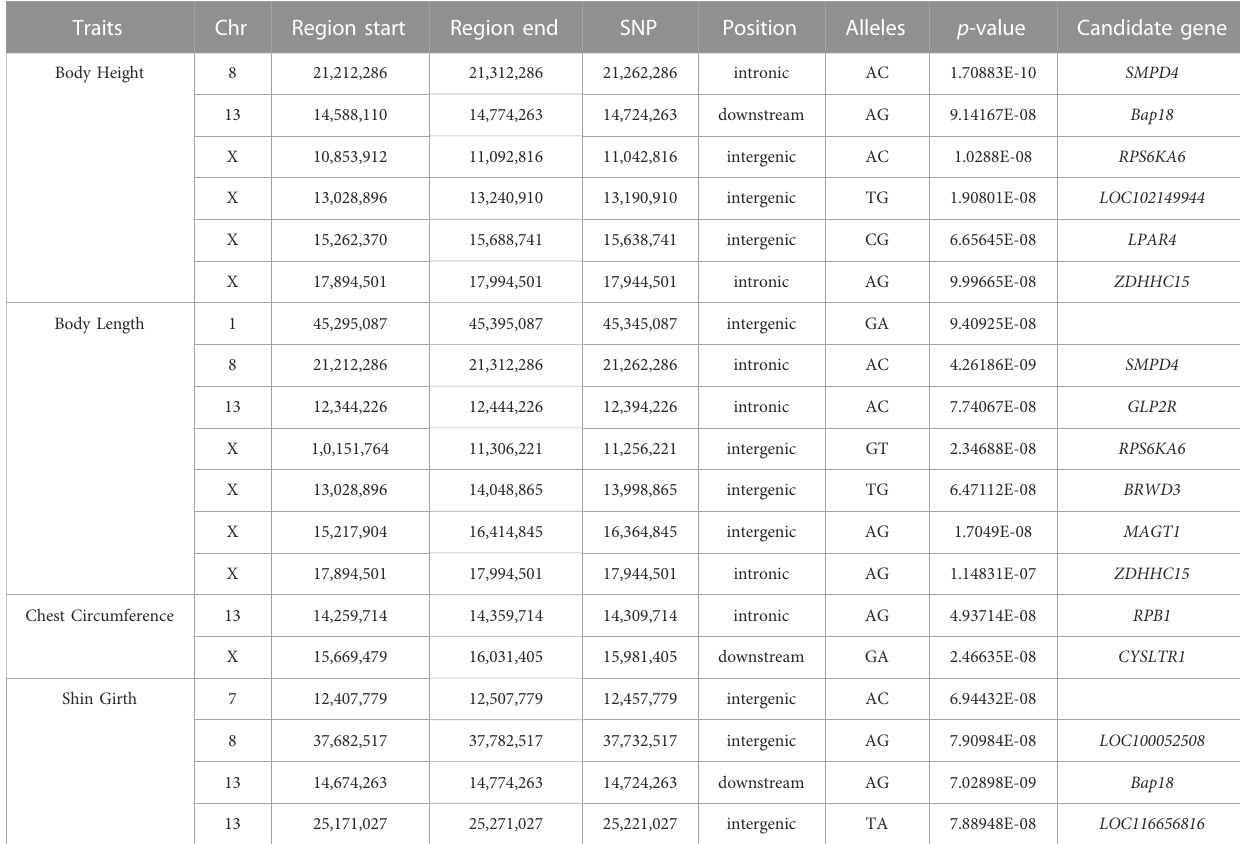
TABLE 3 Candidate genes signi fi cantly associated with body size traits as revealed by genome-wide associated study. Traits Chr Region start